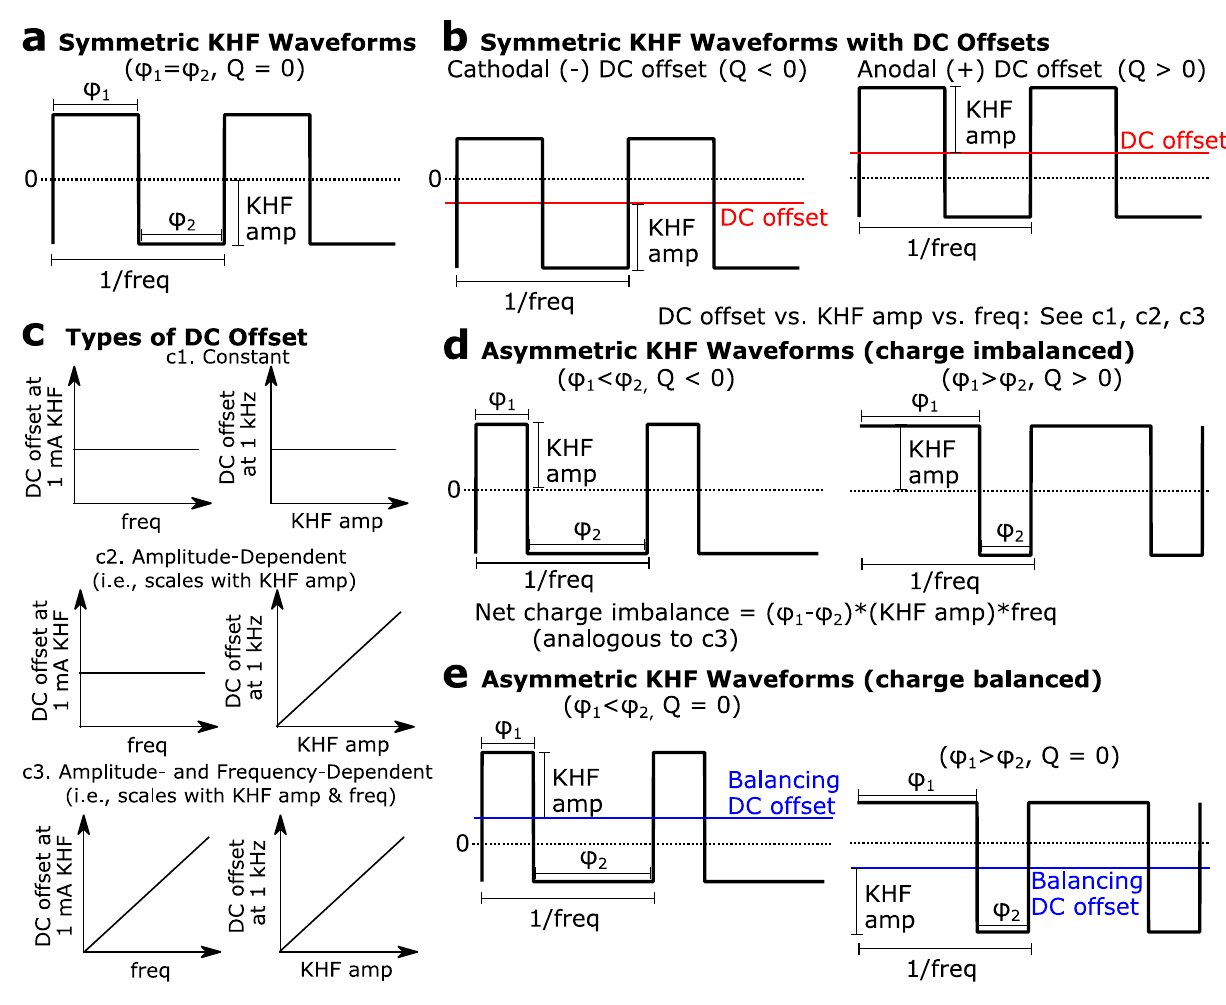
Figure 1. Waveforms tested to independently analyze blocking effects of DC offset types, asymmetric charge imbalance, and asymmetry. KHF amplitude was defined as half of the peak-to-peak amplitude of each waveform. ( a ) Symmetric KHF waveform with zero net charge per unit time (Q = 0). ( b ) Symmetric KHF waveforms with added DC offsets, where symmetry was defined as equal duration phases. Net charge per unit time (Q) was either negative (cathodal DC offset) or positive (anodal DC offset). ( c ) Types of DC offset added to symmetric KHF waveforms. DC offsets were either constant (i.e., independent of KHF parameters) (c1), amplitude-dependent (i.e., scaled with KHF amplitude only) (c2), or amplitude- and frequency-dependent (i.e., scaled with both KHF amplitude and frequency) (c3). ( d ) Asymmetric KHF rectangular waveforms were constructed from the symmetric waveform by defining unequal phase durations. Differences in phase durations (± 2, 3, 4 μs) were independent of waveform frequency, such that the net charge per unit time scaled linearly with KHF amplitude and with frequency, analogous to the DC offset type illustrated in (c3). ( e ) Asymmetric waveforms with a compensatory DC offset that produced zero net charge per unit All waveforms were evaluated at positive and negative polarities, corresponding to positive or negative DC offsets or phase differences (Fig. 1b,d,e). Unless otherwise specified, we refer to polarity in terms of the proxi- mal contact of the bipolar blocking electrode, such that negative (or cathodal) DC and positive (or anodal) DC correspond to current sinks and current sources at the proximal electrode contact, respectively (see Fig. 2 and corresponding Methods text for electrode orientation details).